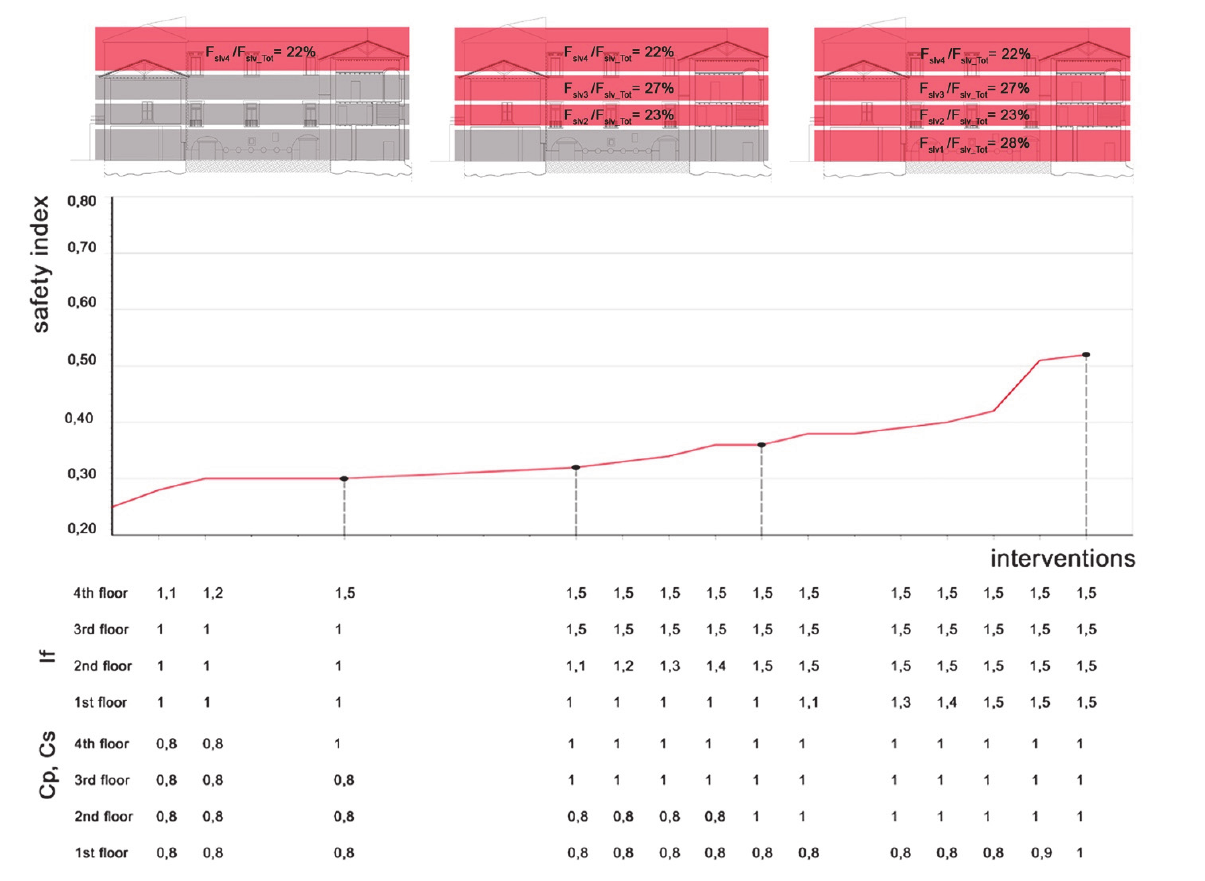
Figure 11: Safety index curve of “Palazzo